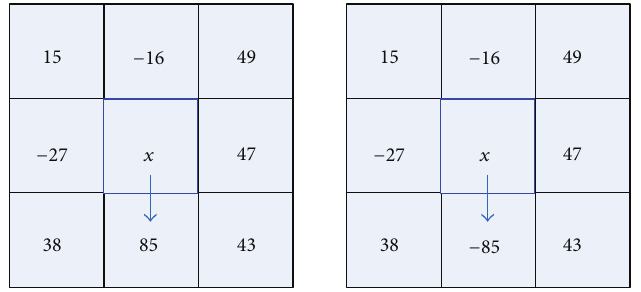
Figure 2: The edge response values of two sample neighborhoods.